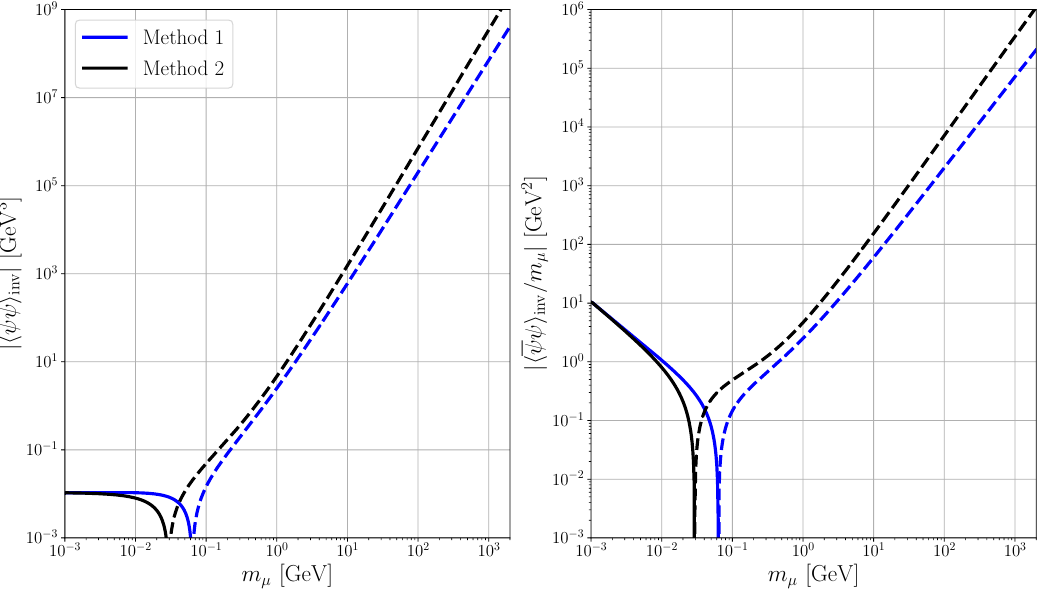
| (left) and the ratio inv µ for fermions in < 0 inv